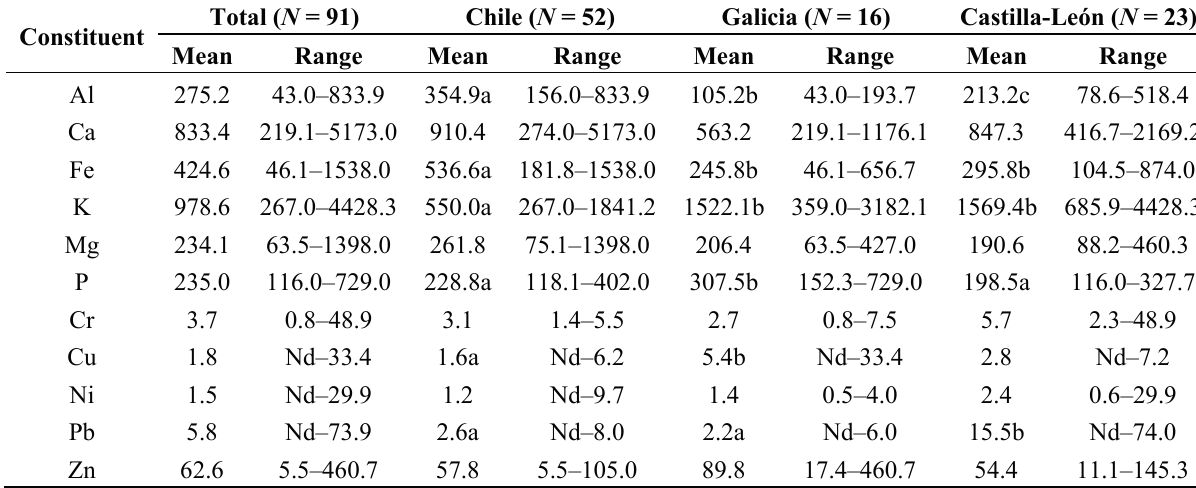
Table 1. Mineral composition of propolis studied according to geographic origin